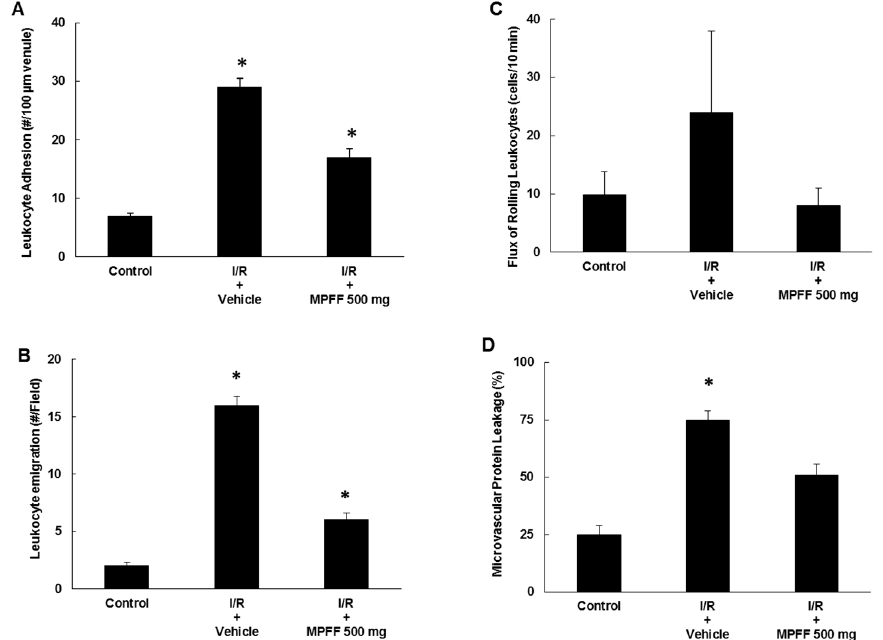
Figure 2. MPFF 500 mg attenuates the postischemic increases in leukocyte adhesion ( A ) and emigration ( B ), flux of rolling leukocytes ( C ), and microvascular protein leakage ( D ) in rat cremaster muscles. I/R = ischemia/reperfusion. Statistically different from * control (nonischemic conditions) and + vehicle: p < 0.05. (Reproduced from [73] with permission from the publisher).